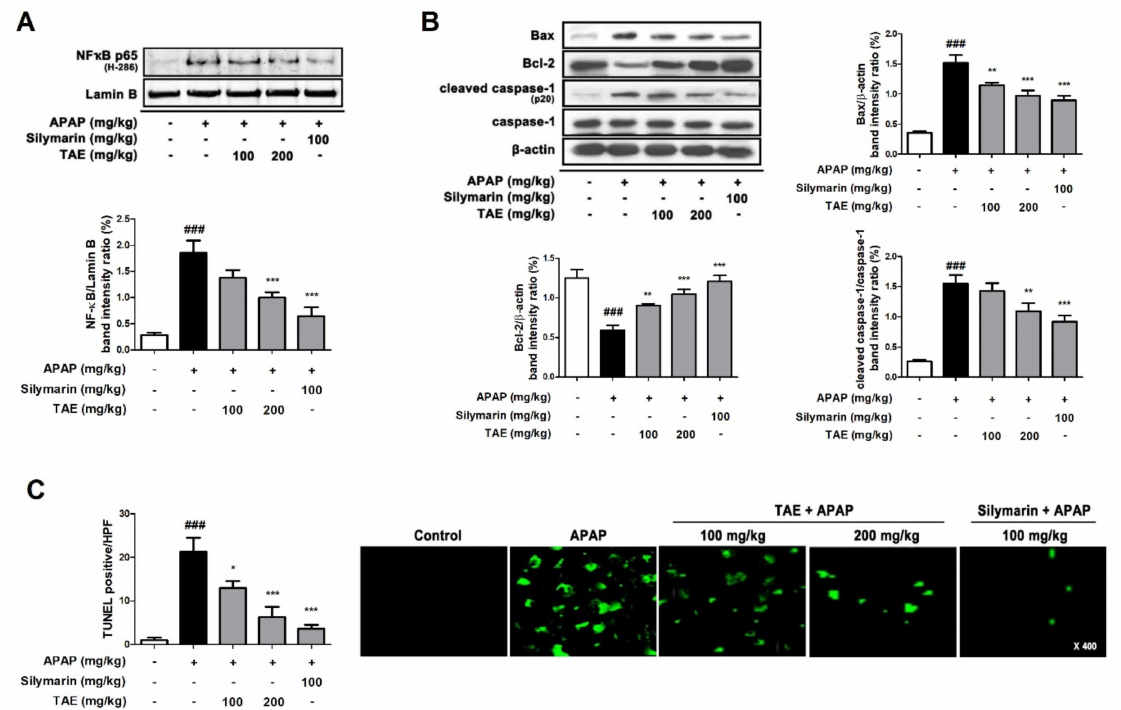
Figure 7. Effect of ethanolic Triticum aestivum sprout extract on hepatocyte apoptosis in mice with N -acetyl-para- aminophenol (APAP)-induced hepatotoxicity. ( A ) Quantification of nuclear translocation of the p65 subunit of NF- κ B. ( B ) Quantification Bax, Bcl-2, cleaved caspase-1, and caspase-1 protein expression. ( C ) Quantification and visualization ( × 400 magnification) of DNA fragmentation. All data are shown as mean ± SD. ### p < 0.001 versus Normal group; * p < 0.05, ** p < 0.01, and *** p < 0.001 versus APAP group. APAP, N -acetyl-para-aminophenol (acetaminophen); Bax, Bcl-2-associated X; Bcl2, B-cell lymphoma 2; Caspase, cysteinyl aspartate specific proteinase; NF- κ B, transcription factors nuclear factor-kappa B; TAE, Triticum aestivum sprouts